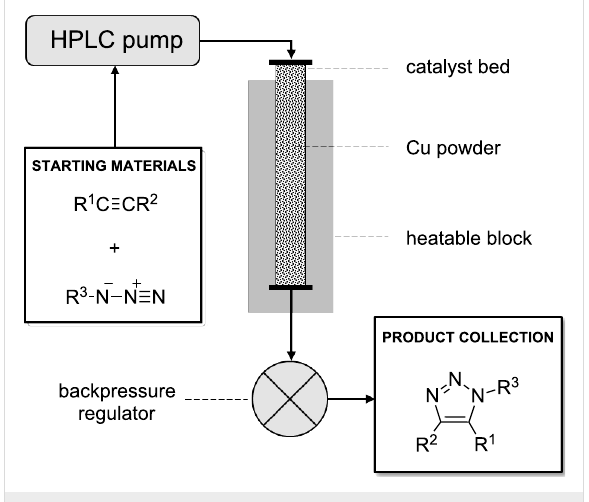
Figure 3: Experimental setup for the CF